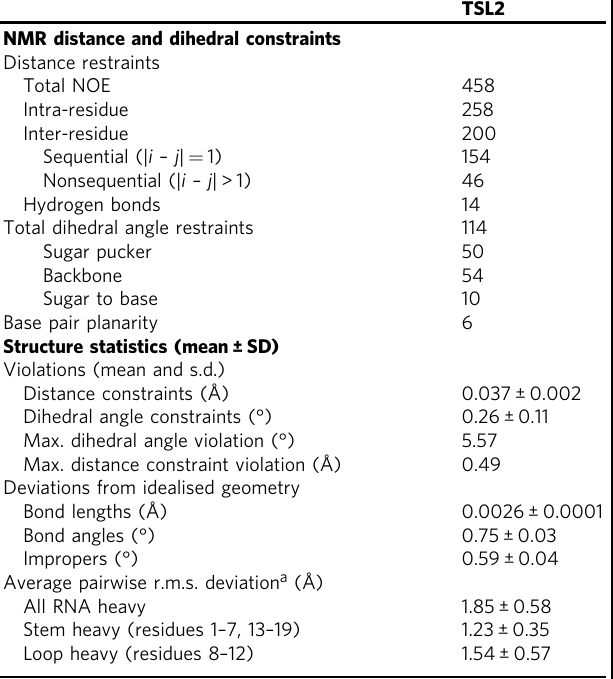
Table 1 NMR and re fi nement statistics for the TSL2 RNA